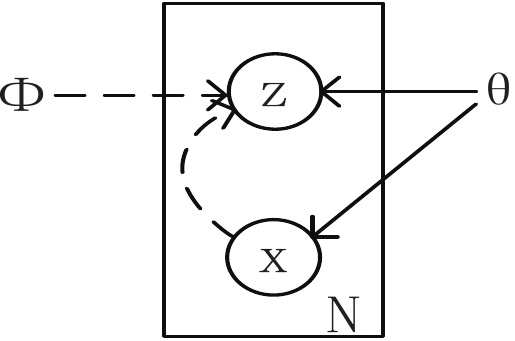
Figure 11. The generation process of variable x.